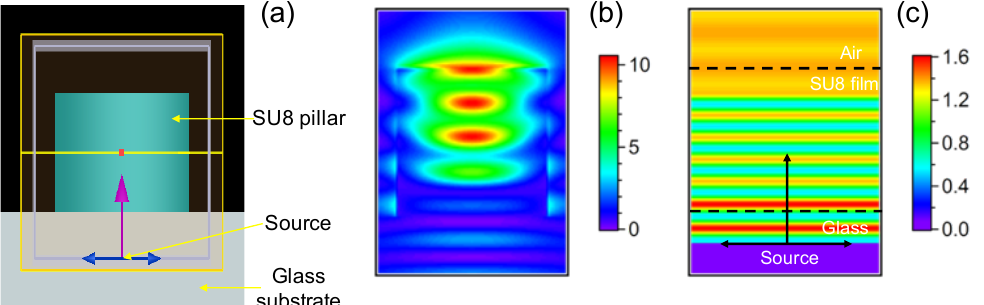
Figure 8. ( a ) Illustration of the model used to simulate the coupling of a light beam and a polymeric pillar. A light beam at 1064 nm–wavelength is emitted from the source and sent towards the cavity ( n glass = 1.5, n SU8 = 1.58). ( b ) Simulation of light intensity inside a polymeric pillar (diameter = 800 nm, height = 1.3 µ m). ( c ) Simulation of light intensity at 1064 nm–wavelength propagating through a polymeric film (thickness = 1.3 µ